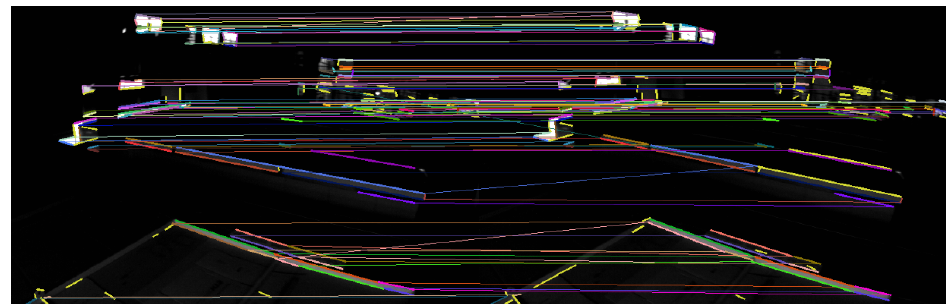
Figure 10. Image with insufficient illumination.